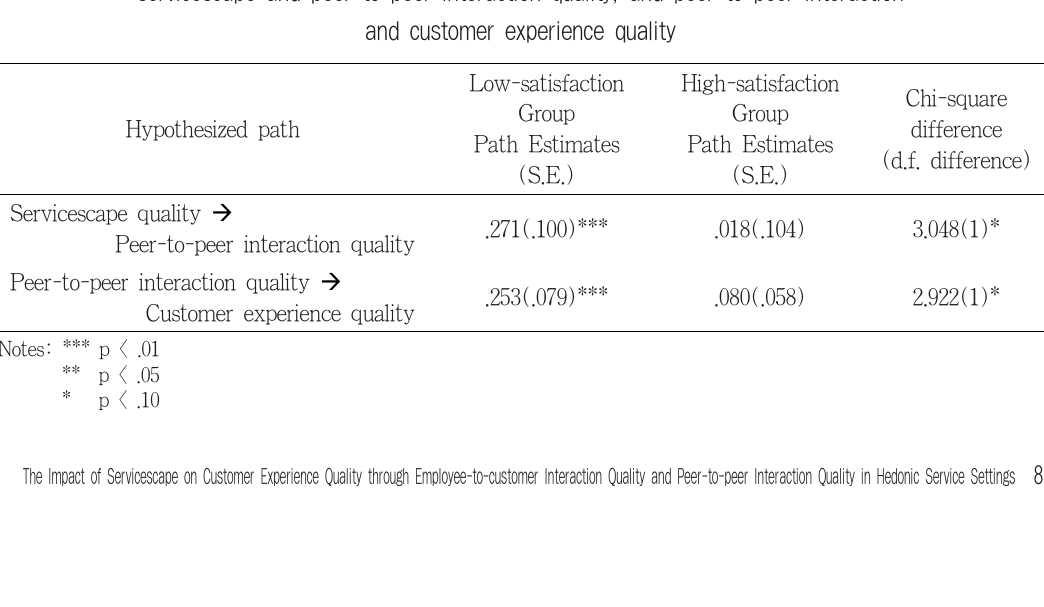
<Table 5> The moderating effect of the level of customer satisfaction on the relationship between servicescape and peer-to-peer interaction quality, and peer-to-peer